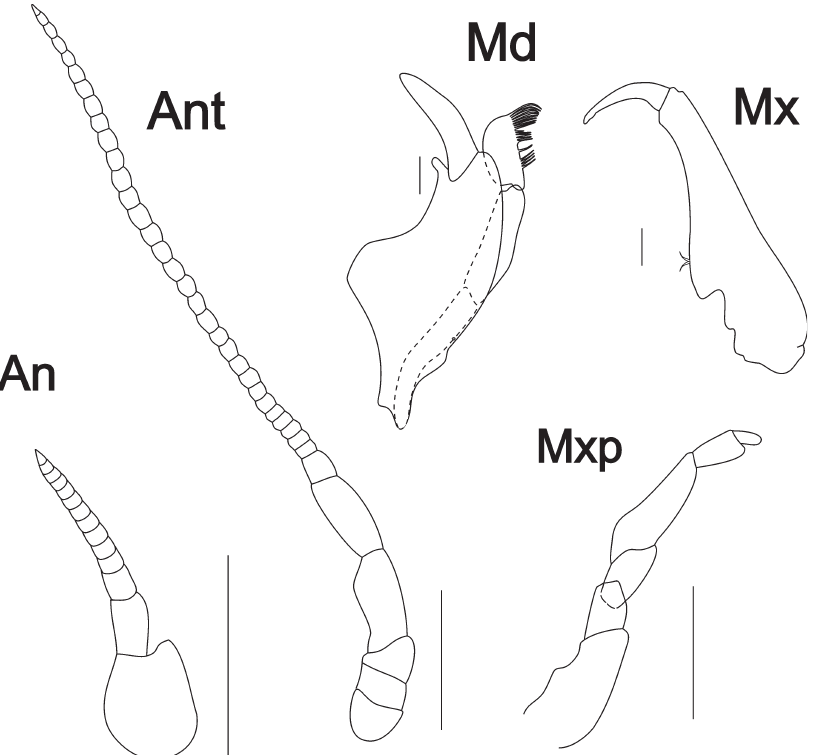
Figure 6. Excorallana lemoscastroi sp. nov., paratype male, 10 mm, (MOUFPE 118), antennula, antenna and mouthparts. Scale = 1 mm.